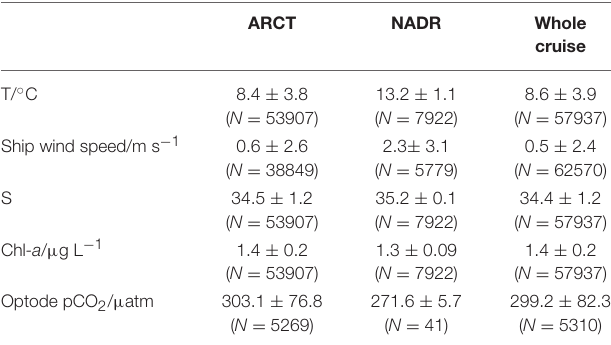
TABLE 3 | Means ± standard deviations of underway measured variables for each biogeographical region (as defined in section Fieldwork